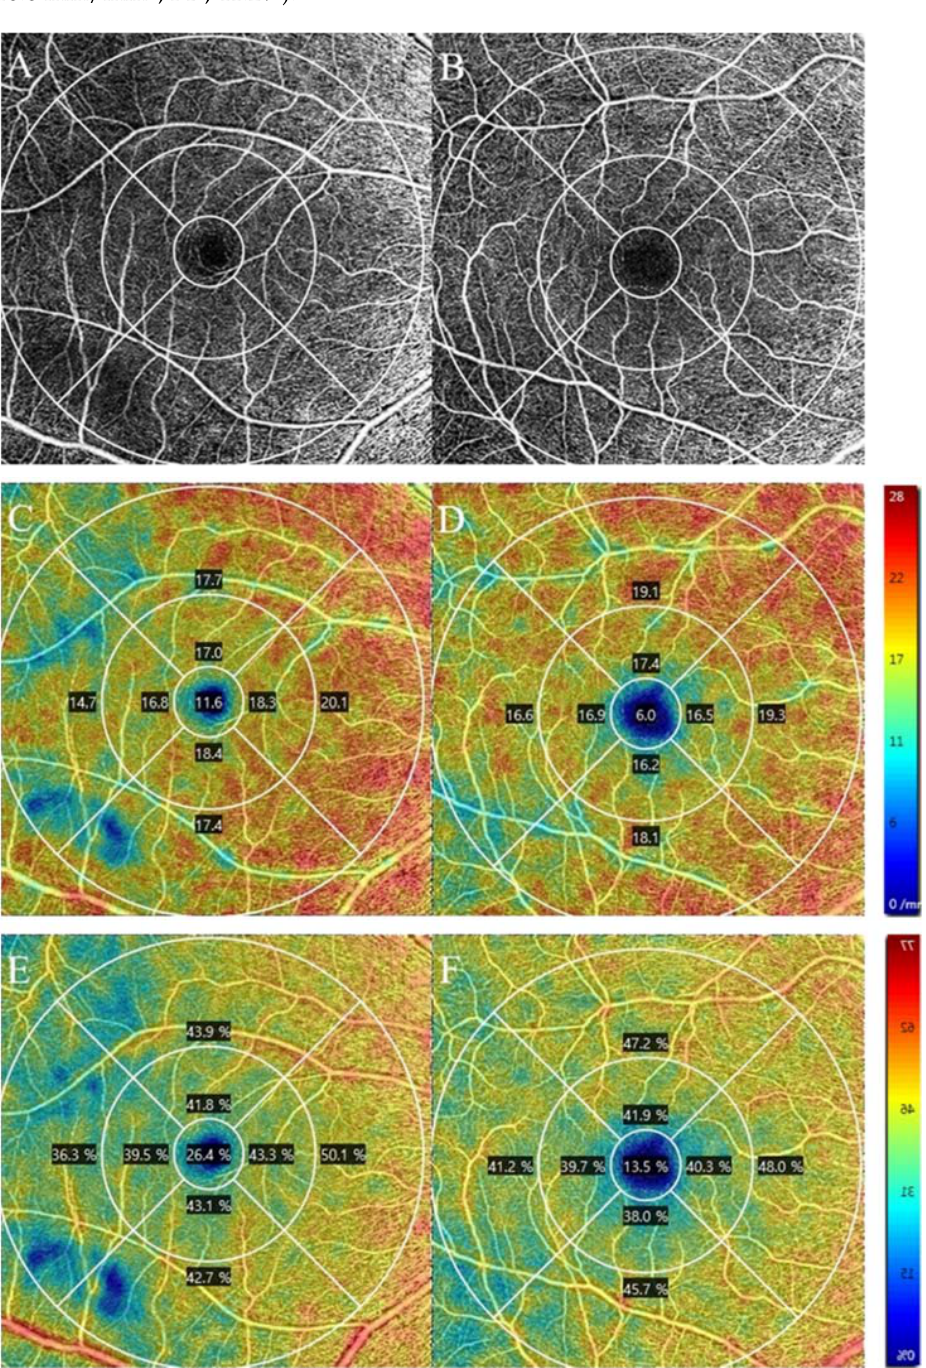
Figure 2. Representative OCTA angiography 6 × 6 mm images of the superficial capillary plexus (SCP) of the right eye from A β‐ positive (A+) MCI and A β‐ negative (A − ) MCI participants. En face OCTA of the A+ MCI shows thinner capillaries in the SCP in the temporal macula than A − MCI ( A , B ). Color maps for the corresponding quantitative vessel density ( C , D ) and perfusion density ( E , F ) showed lower microcirculation of temporal macula in the A+ MCI group than in the A − MCI group. Abbreviations: A β , beta ‐ amyloid; MCI, mild cognitive impairment; MMSE, Mini ‐ Mental State Examination; OCTA, optical coherence tomography angiography.